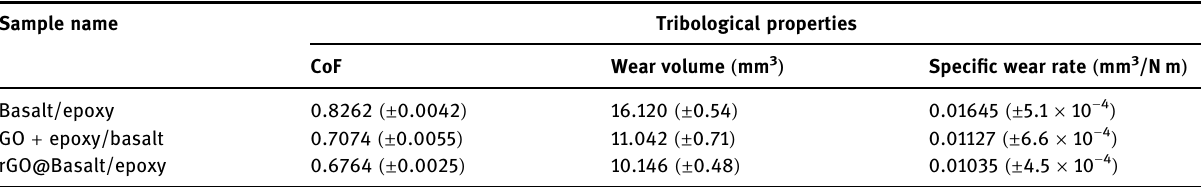
Table 2: Summarized values of CoF, wear volume, and speci fi c wear rate of basalt/epoxy, GO + epoxy/basalt, and rGO@Basalt/epoxy composites wear specimens